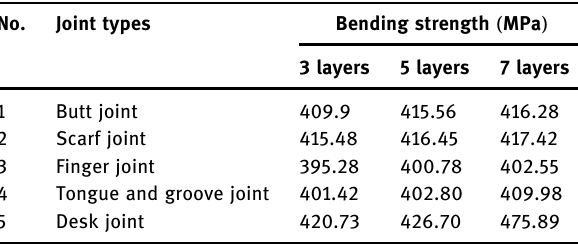
Table 7: Result of bending test under di ff erent joints